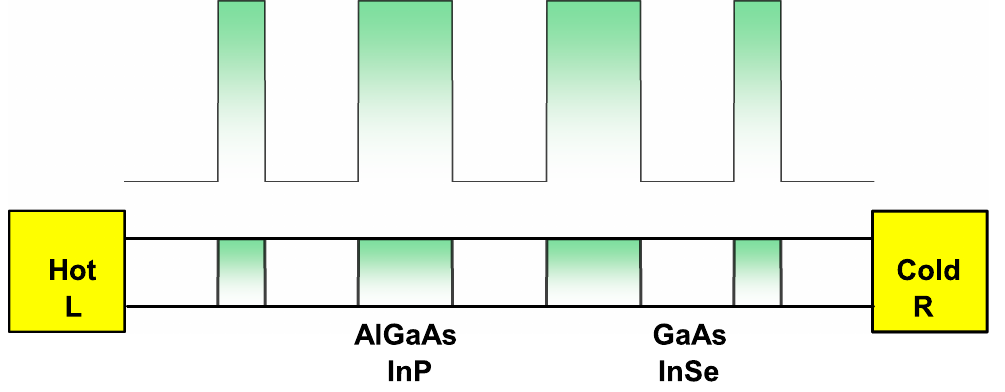
Figure 6. Schematic diagram of the SL made up of a system of GaAs (InSe) wells and Al 0.3 Ga 0.7 As (InP) barriers. The lower part represents the device connected to hot-left and cold-right reservoirs that also act as emitters and collectors. The top represents the bottom of the conduction band of the system. The width of the wells and the two central barriers have been set at 5nm, and the barriers at the left and right are set at 2.5nm (see Figure 2(c3)).